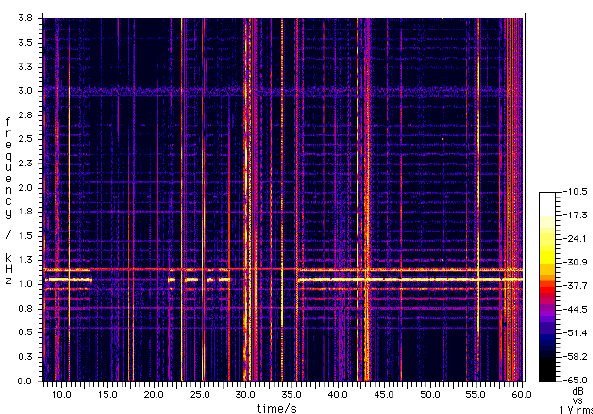
Fig. 2. The first 60s of the ripple control spectrum taken from a loop antenna on Swampy Summit (Dunedin). The signal starts at 16:30:08 NZLT on 9 April 2003. Frequencies below 500Hz have been filtered, as a strong harmonic exists at